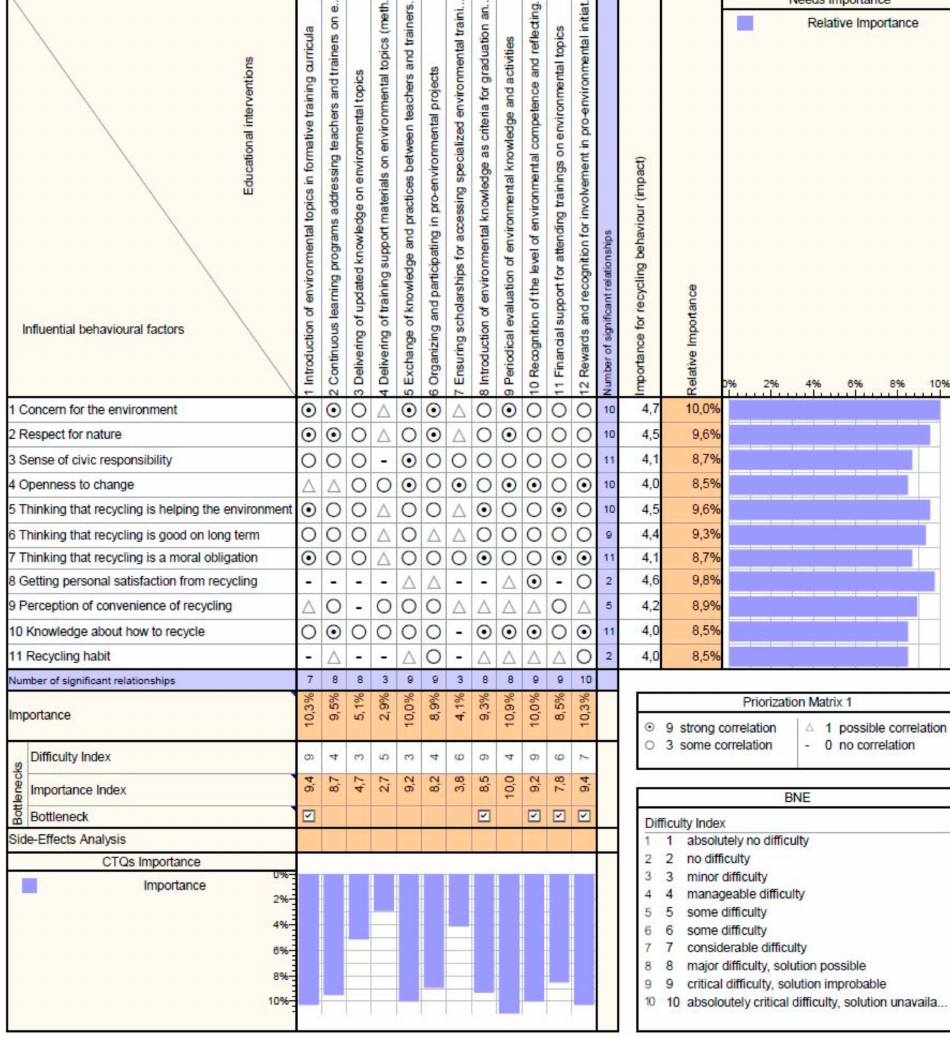
Figure 4. Correlation Matrix for interventions addressing teachers and trainers—output from the Qualica QFD